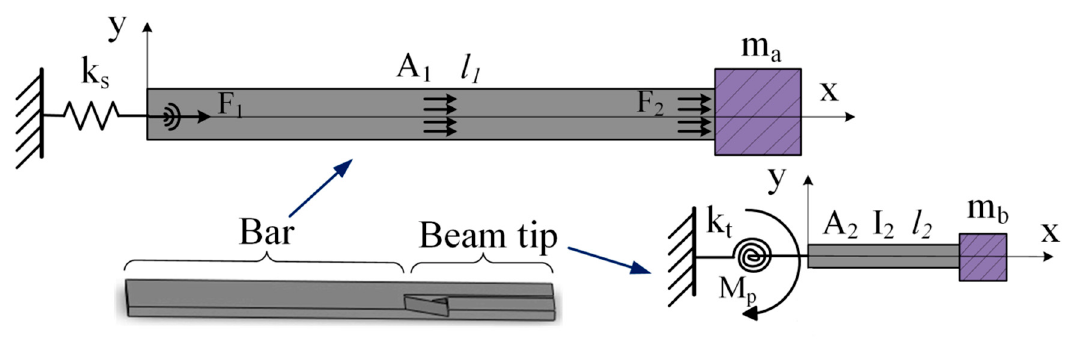
Figure 2. The equivalent model of beam driven by longitudinal vibrations.